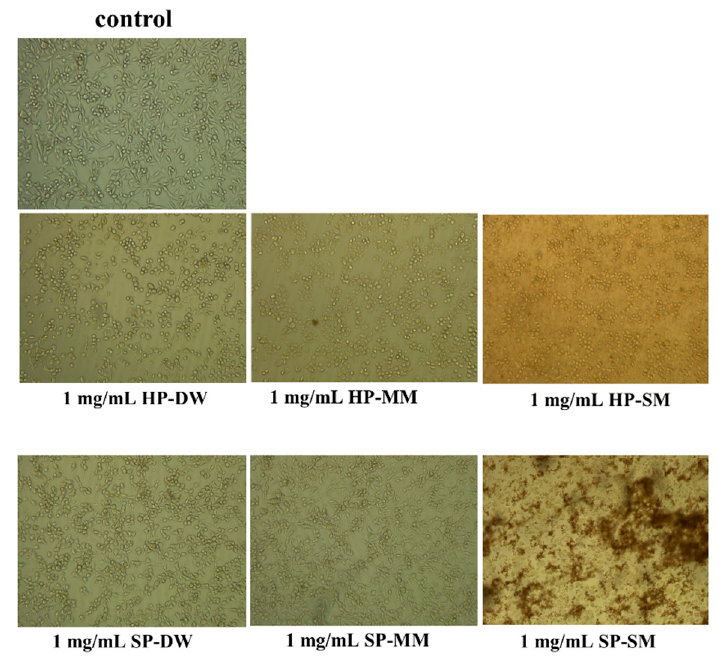
Figure 5. Effect of hot and sweet pepper extracts on prostate cancer cell line 3 (PC3) cells under inverted microscope using 10× objective.